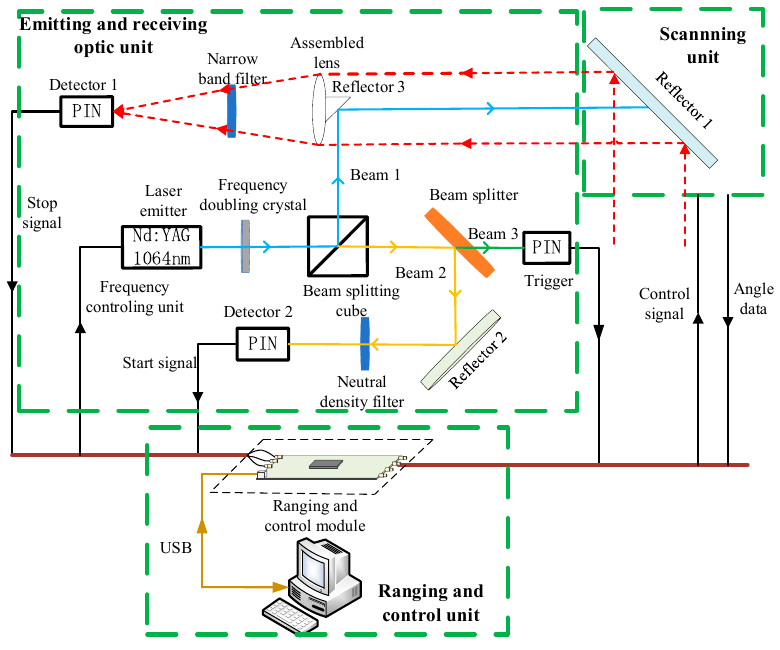
Figure 1. Lab-build LiDAR system.